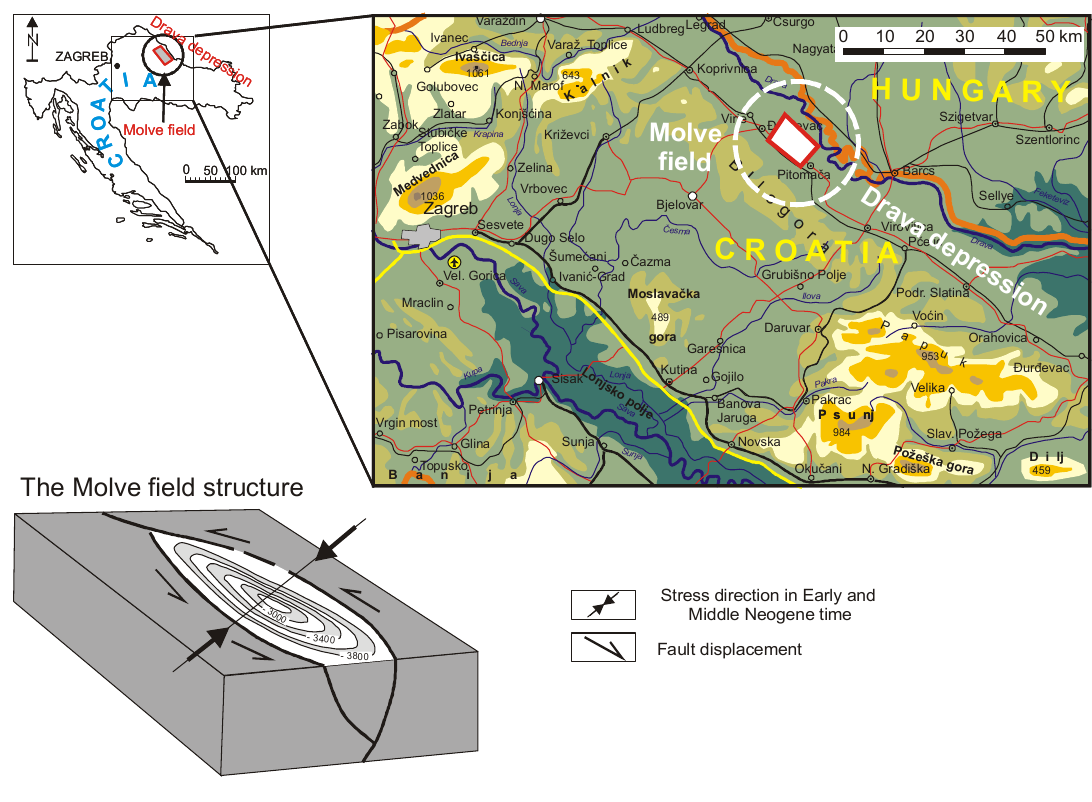
Figure 13. Geographical location of the Molve structure [44]. Processes 2020 , 8 , x FOR PEER REVIEW